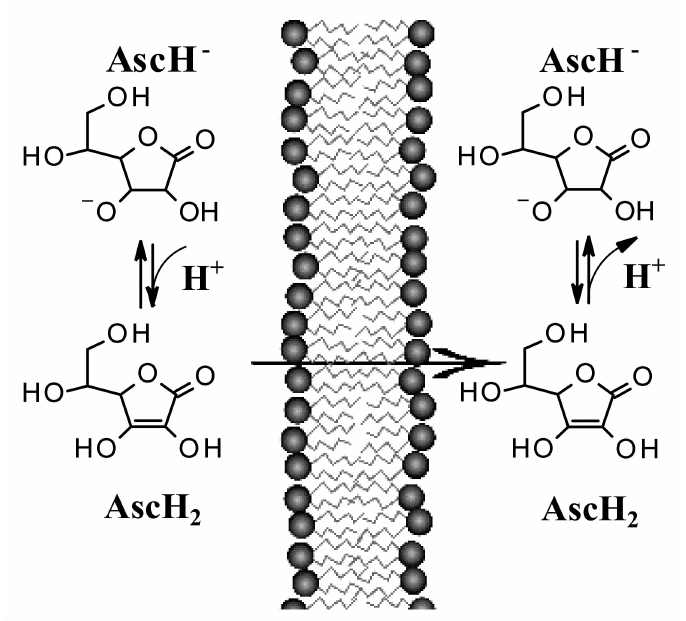
Figure 4. Only the protonated form AscH 2 is able to cross biological membranes by passive diffusion. The monoanionic form is unable to pass lipid